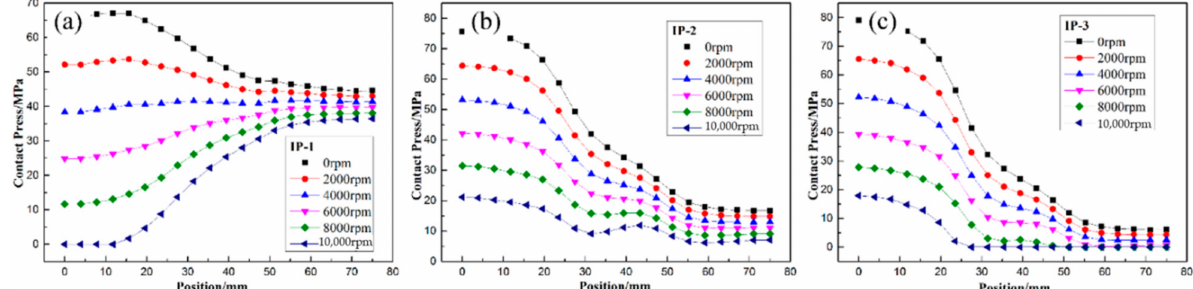
Figure 11. The distribution of contact stress of CTW rotor with winding tension of ( a ) CT-1 case; ( b ) CT-2 case; and ( c ) CT-3 case.